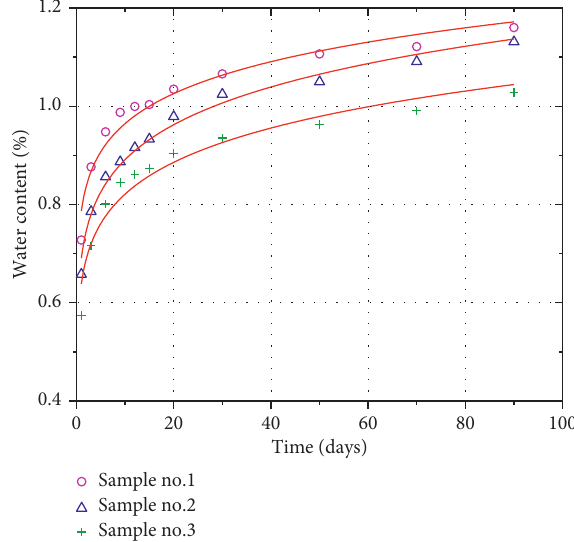
Figure 3: Variation of water content with time for the immersed